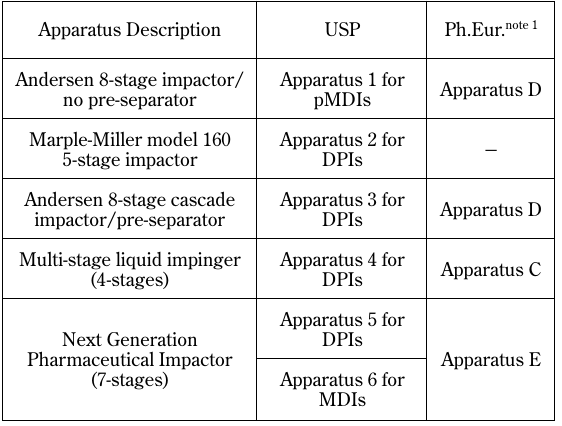
Table 1 Particle size analysis methods for medical aerosols listed in the current USP †  and Ph.Eur.